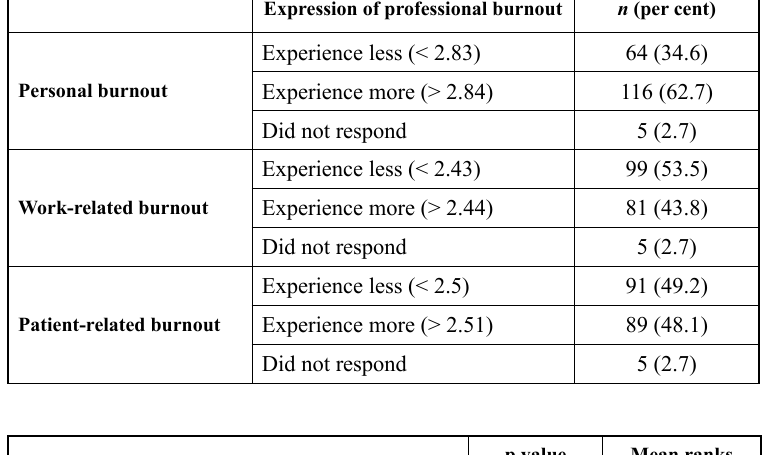
Table 7. Statistical and practical impact Values of Copenhagen Burnout Inventory Subscales by age